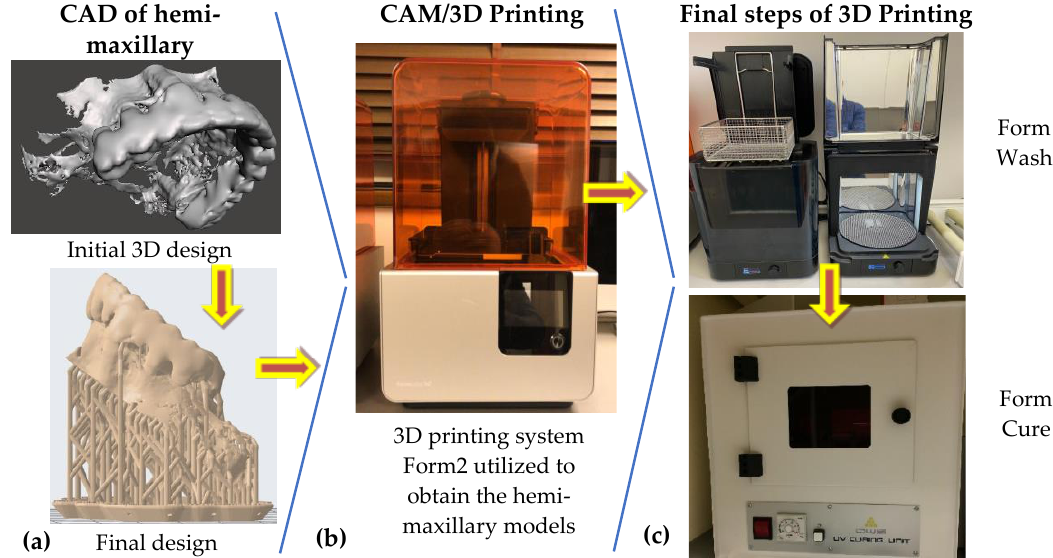
Figure 3. The steps of the design and manufacturing of a hemi-maxillary: ( a ) CAD-initial and final design; ( b ) CAM-3D printing, with a Form2 system (Formlabs Inc., Somerville, MA, USA); ( c ) final two steps of the manufacturing process, i.e., washing and curing of the obtained polymer-based 3D-printed models.